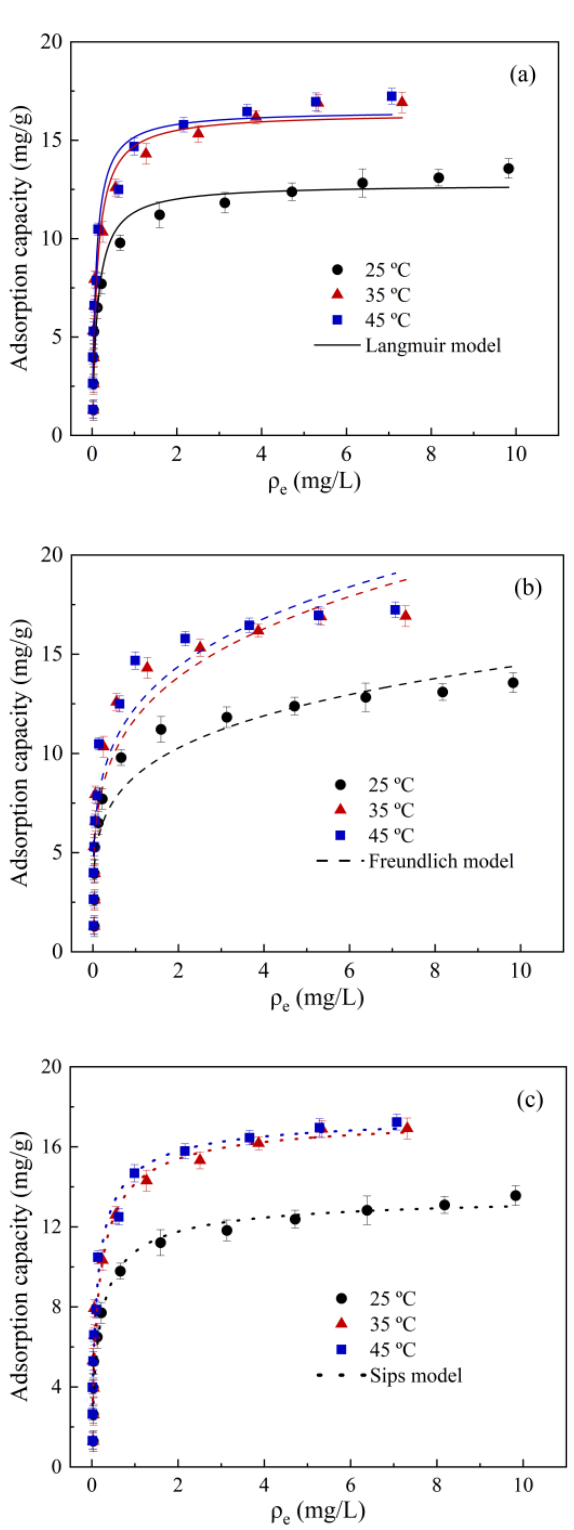
Figure 3. Isotherm model fitting of diuron adsorption by SDMBC600: ( a ) Langmuir model; ( b ) Freundlich model; ( c ) Sips model.